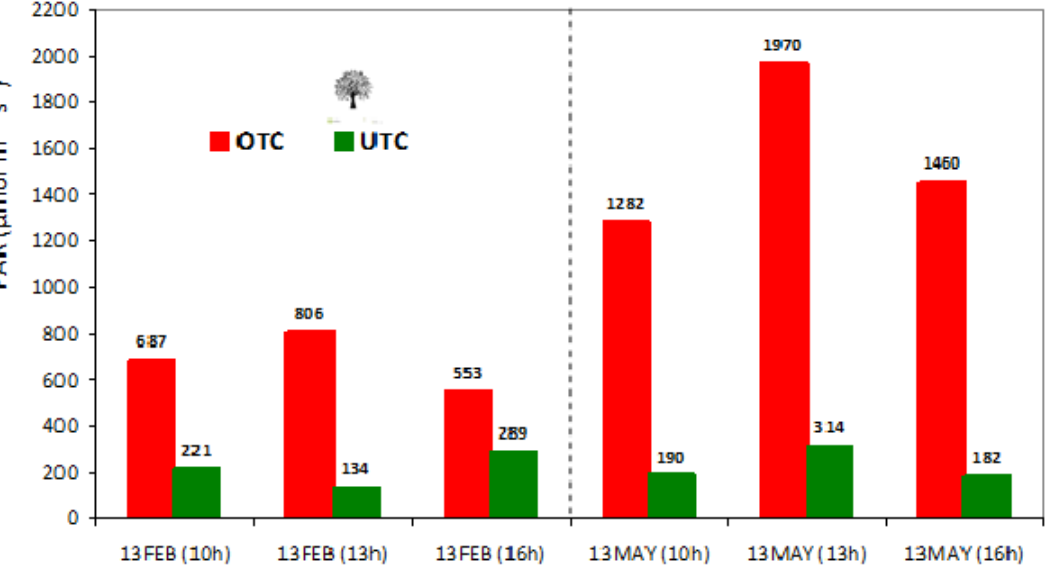
Figure 7. Photosynthetically active radiation (PAR), average of 12 sampling points in each situation (under tree canopy, UTC, and outside tree canopy, OTC), for each date–hour measurement in 2018.